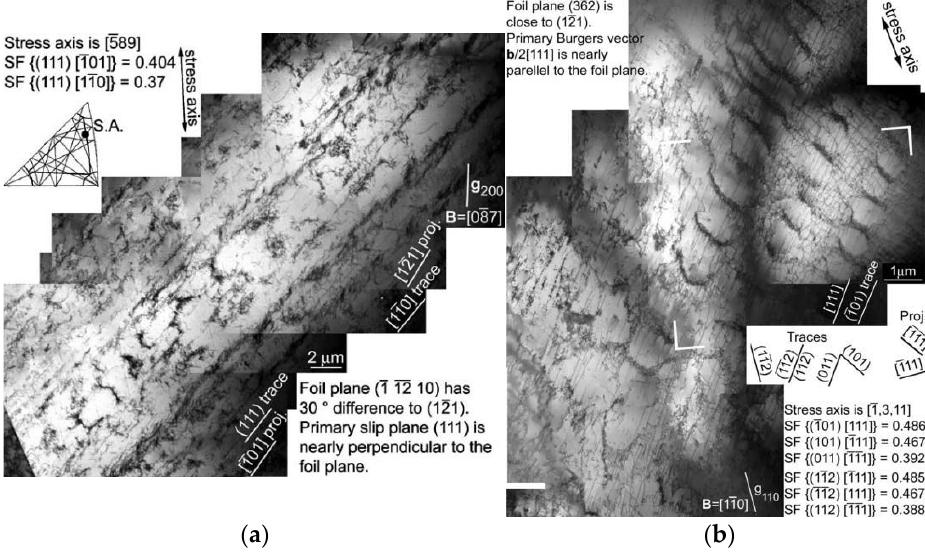
Figure 5. Dislocation structure in the grains of the stainless steels cycled to the end of the fatigue life ( a ) austenitic 316L steel, ε ap = 1 × 10 − 3 ( b ) ferritic X10CrAl24 steel, ε ap = 2 × 10 − 3 . ( a ) austenitic 316L steel, ε − 3 ( b ) ferritic X10CrAl24 steel, ε ap = 1 × 10